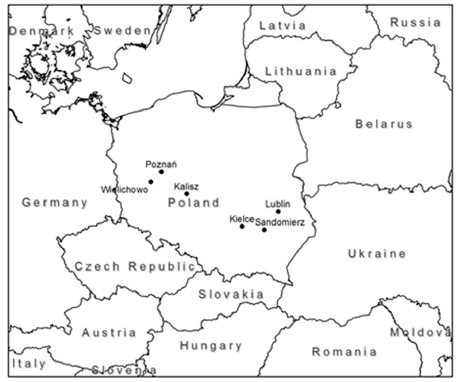
Figure 1. Location of the meteorological stations used in the study.